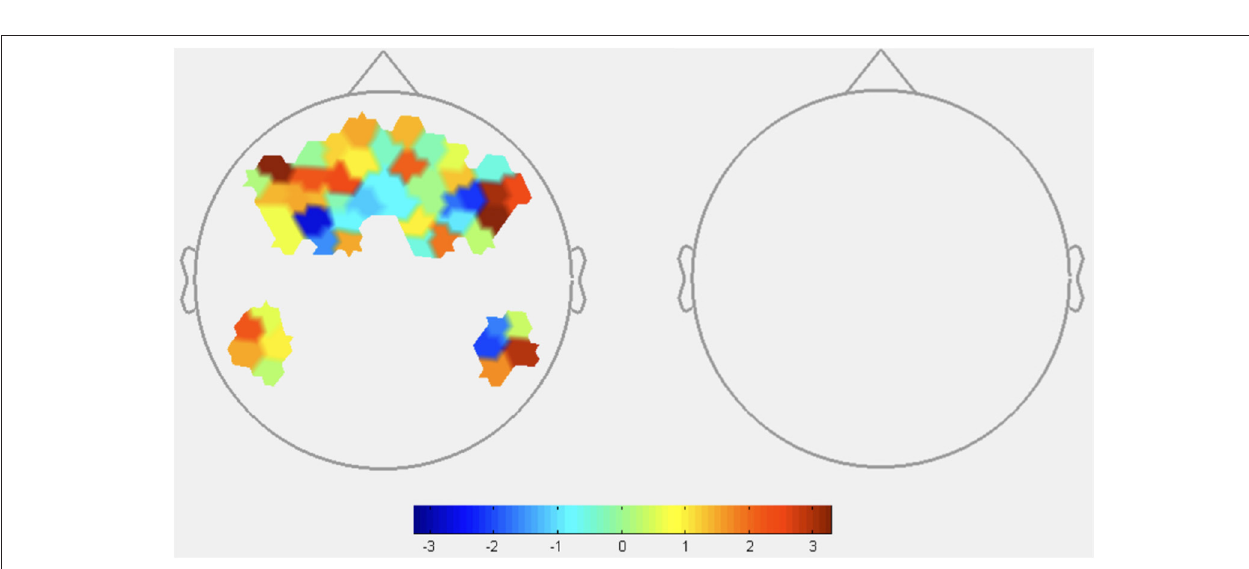
FIGURE 7 | HbR contrasts between low reliability and high reliability conditions: (T Low R Low + T High R Low )–(T Low R High +T High R High ). This image displays all t -values as there were no channels that were statistically significant ( p < 0.05). Red coloration indicates less activation (higher HbR) during low reliability conditions. Blue coloration indicates more activation (lower HbR) during high reliability